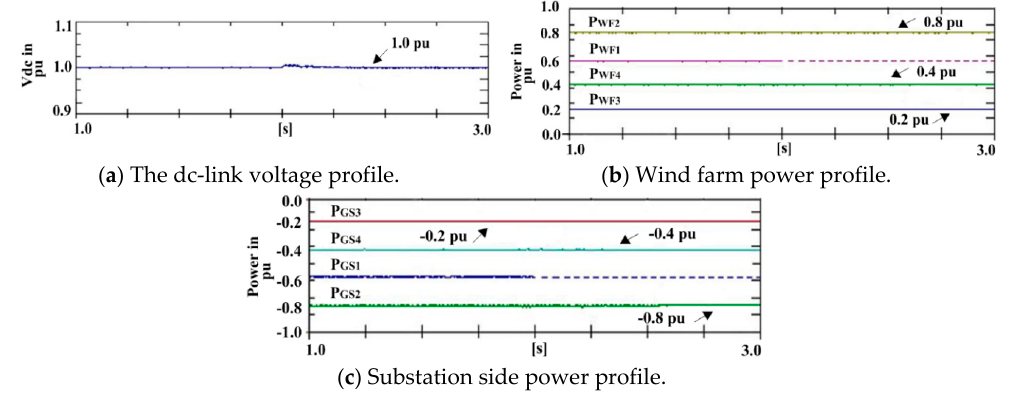
Figure 10. A dc fault on the line L 41 of the WF ring.